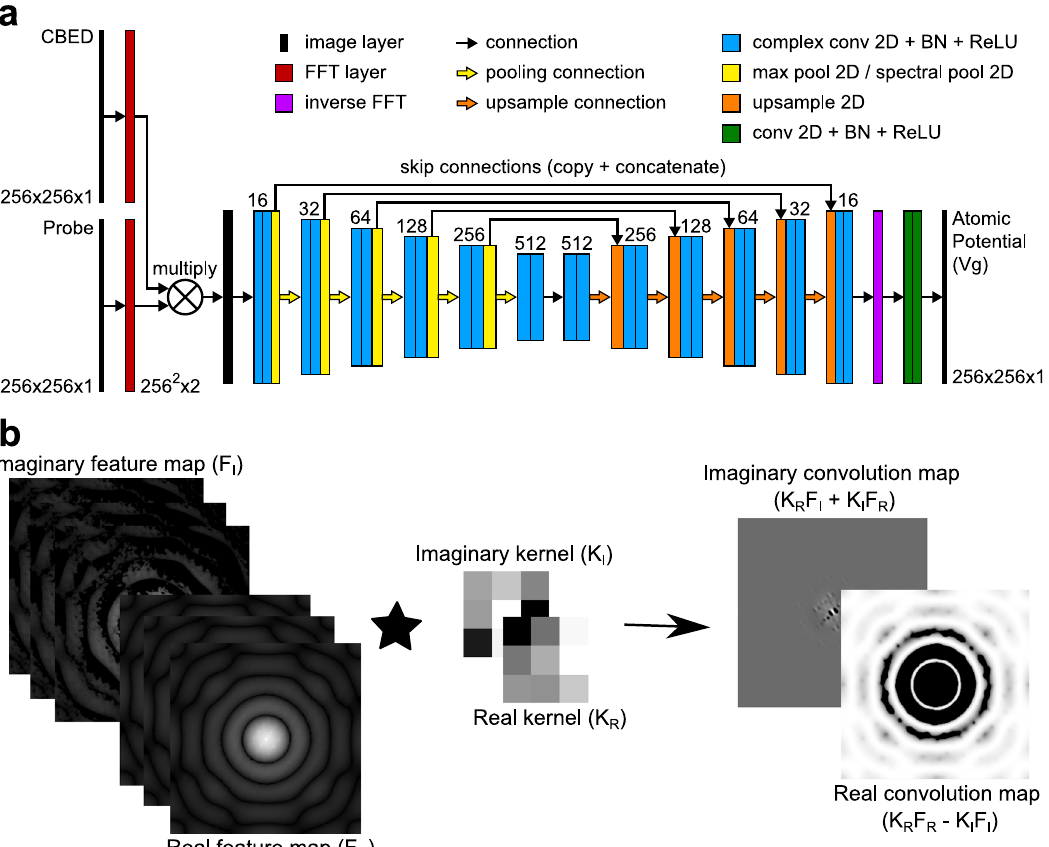
Fig. 8 FCU-Net network architecture. a Architecture of the neural network implemented to predict pixel-wise regression maps of the projected atomic potential. b Complex convolution operation performed on CBED images cross-correlated with vacuum probe